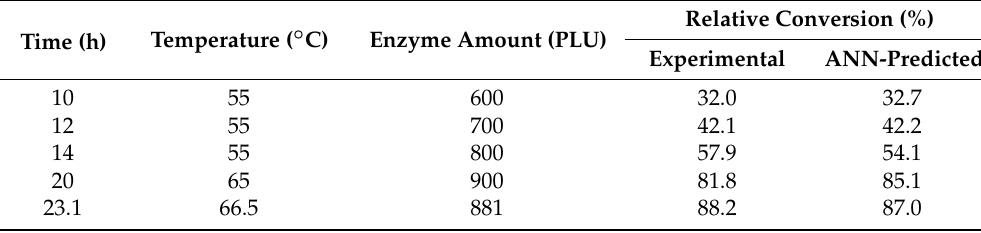
Table 2. Validation of ANN ‐ predicted synthesis data of 2 ‐ ethylhexyl salicylate.